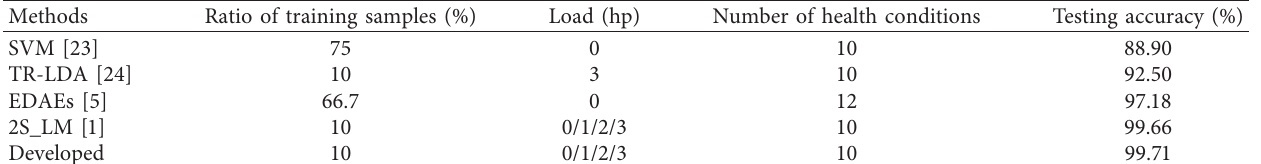
Table 2: Performance comparison of different methods with the motor bearing dataset (unit: